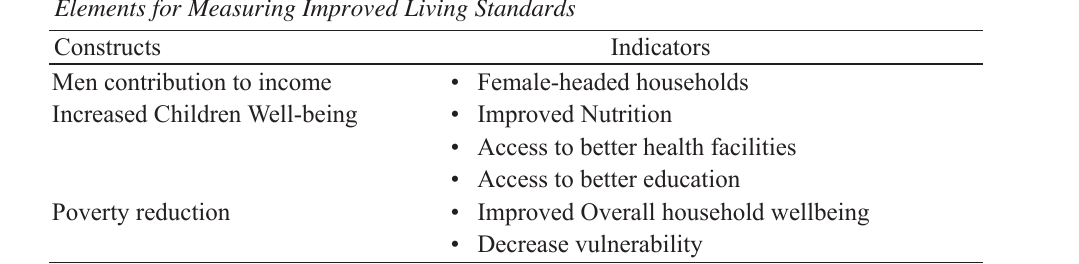
Table 3 Elements for Measuring Improved Living Standards